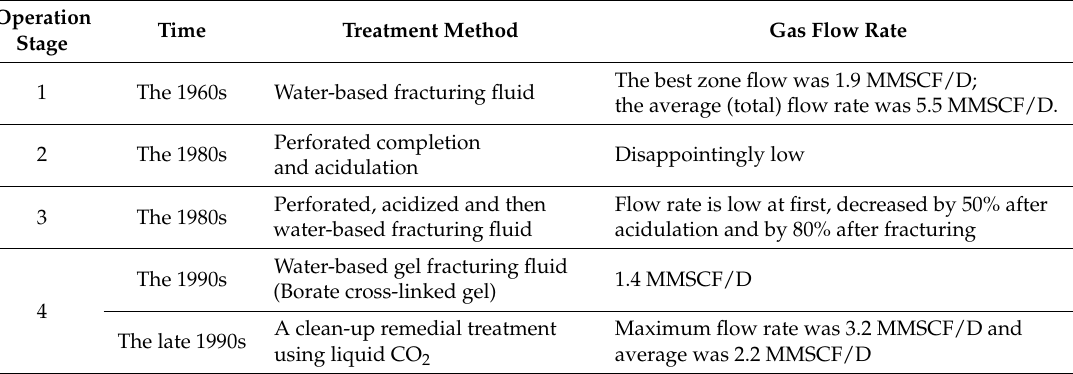
Table 4. Previous and alternative treatments for wells in specific